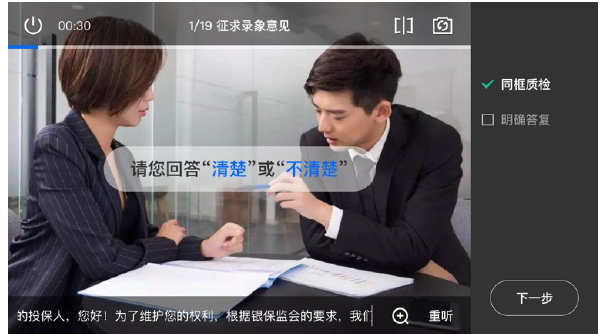
Fig. 5 Video recording interface of intelligent dual-recording APP on the mobile terminal